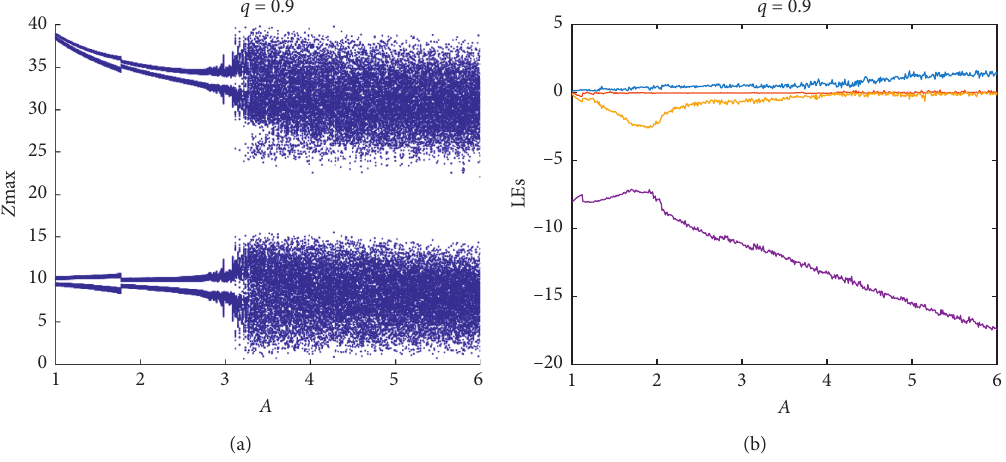
Figure 5: (a) Bifurcation diagram of parameter A of system (1) with q � 0.9; (b) Lyapunov exponent spectrum of parameter A of system (1) with q �